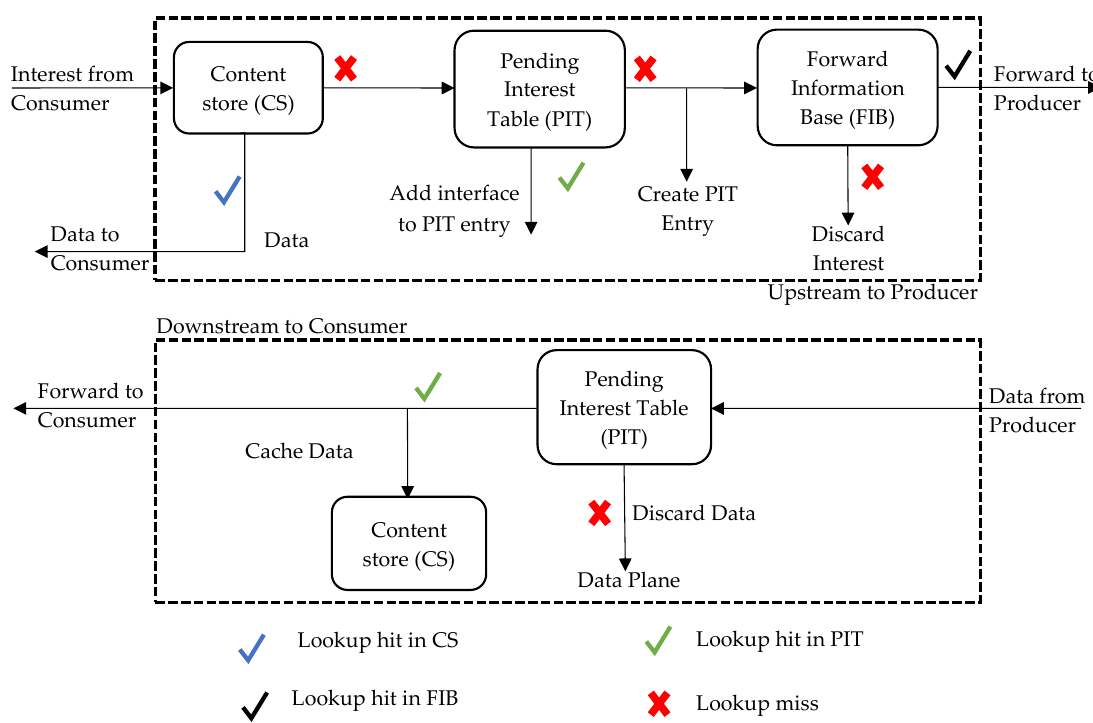
Figure 3. NDN packet forwarding process (reproduced according to “Name Data Networking”)